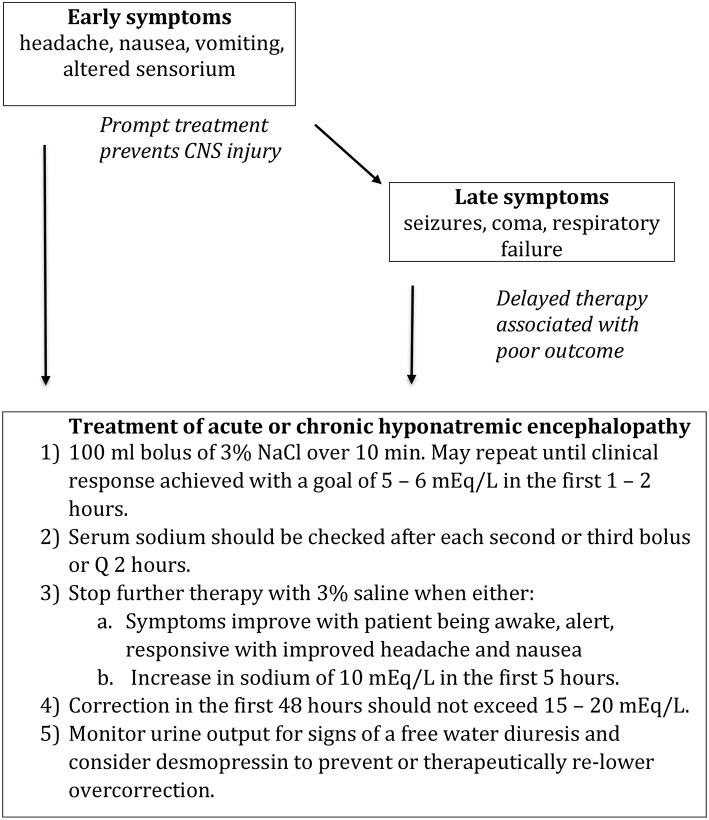
Treatment of hyponatremic encephalopathy. Modified from Achinger and Ayus (63).